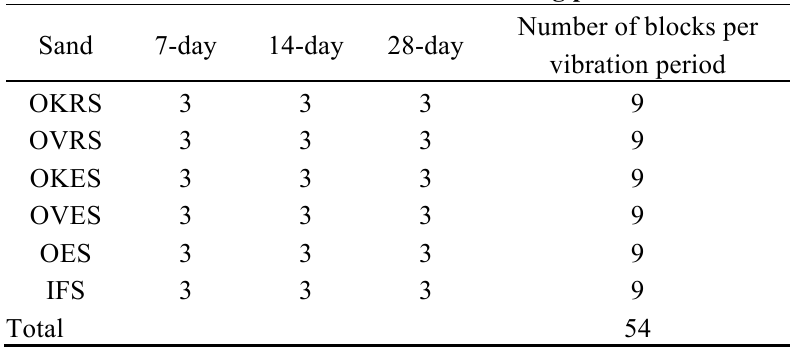
Table 1. Number of blocks per vibration period for each block type without combining fine